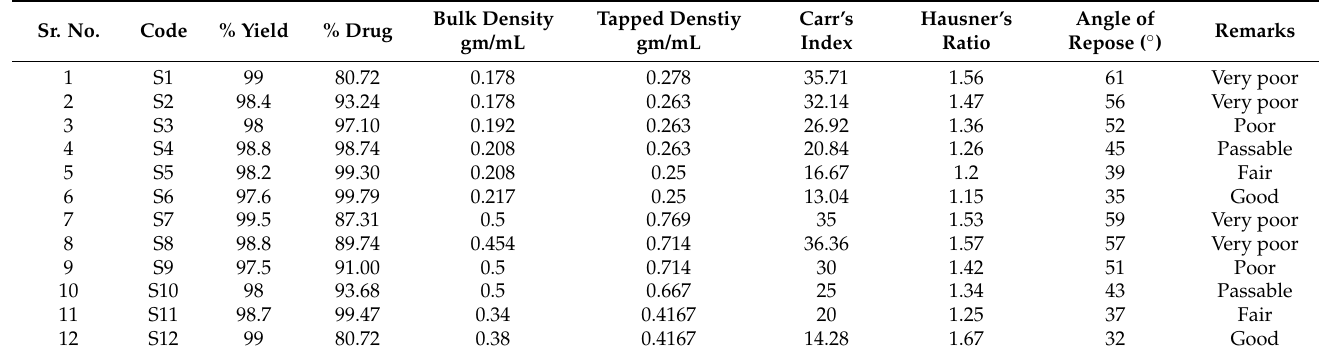
Table 3. % yield, entrapment efficiency, and flow properties of BSD and